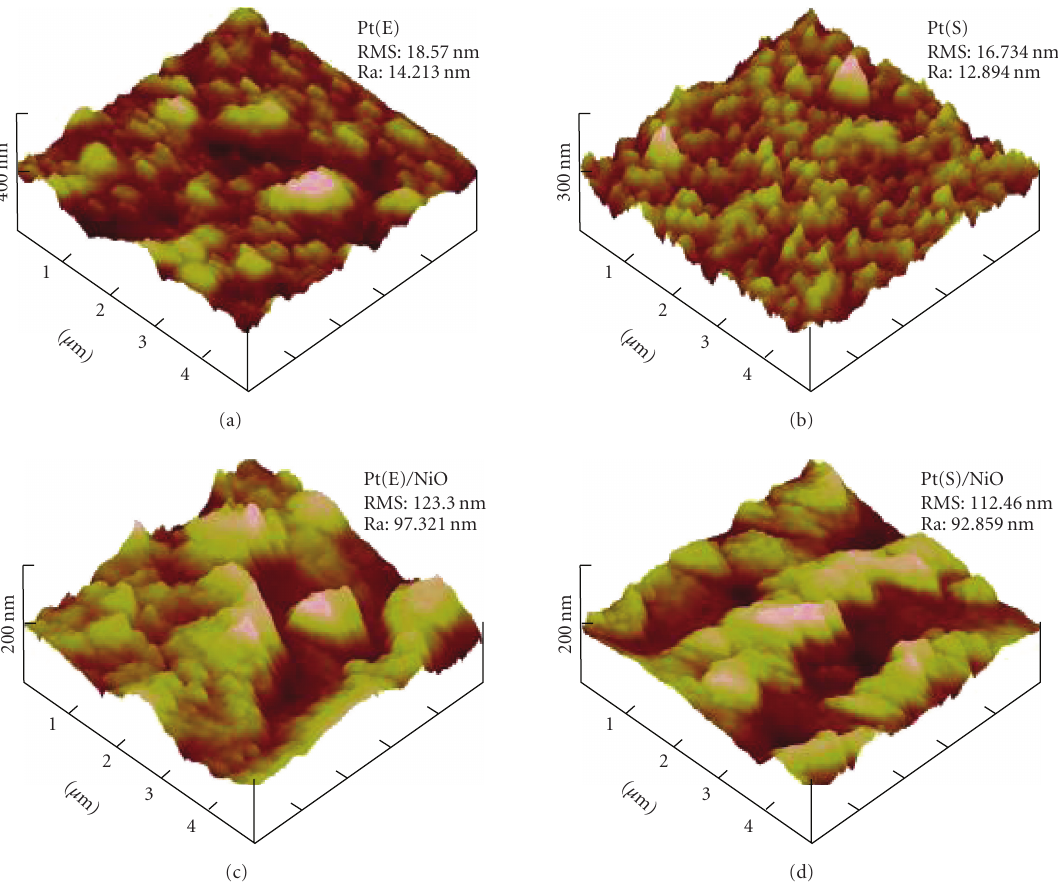
Figure 5: The 3-D micro-structure of counter electrodes. (a) Pt(E), (b) Pt(S), (c) Pt(E)/NiO, and (d) Pt(S)/NiO.